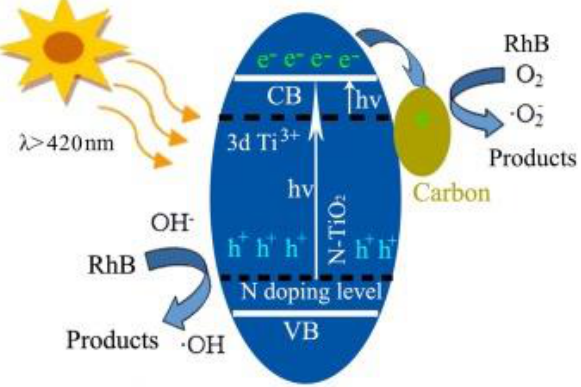
Figure 8. Schematic diagram of the charge transfer and the proposed reaction mechanism over N-doped TiO 2 / C nanocomposites under visible light irradiation. Reproduced from [70]. Copyright (2017),